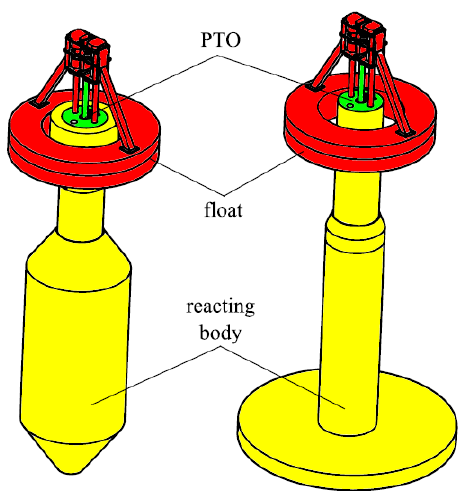
Figure 11. Wavebob ( left ) and Powerbuoy ( right ) two-body point absorber models [5].